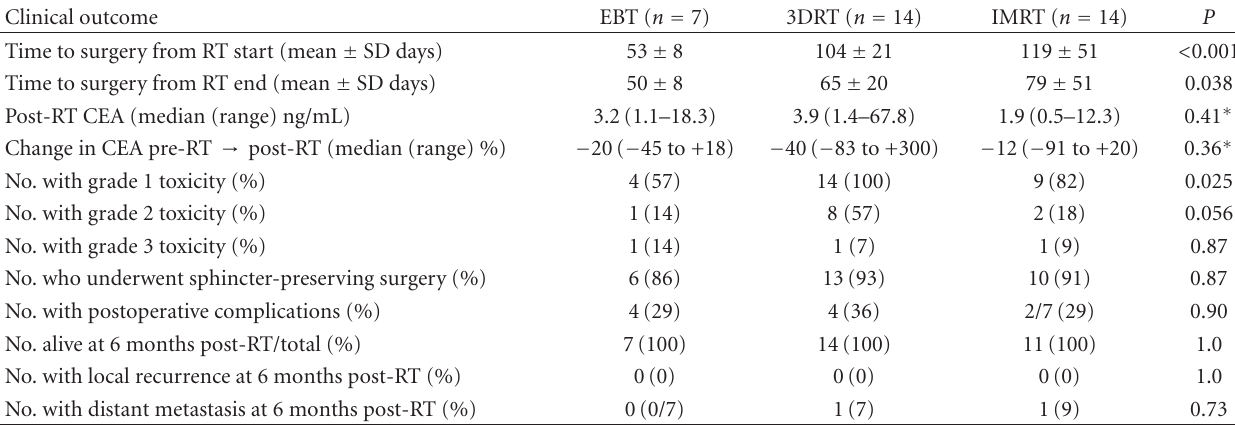
Table 2: Clinical outcomes broken down by EBT, 3DRT, and IMRT groups with statistical comparison. EBT: endorectal brachytherapy; 3DRT: 3D conformal radiotherapy; IMRT: intensity-modulated radiotherapy; RT: radiotherapy; CEA: carcinoembryonic antigen. Clinical outcome